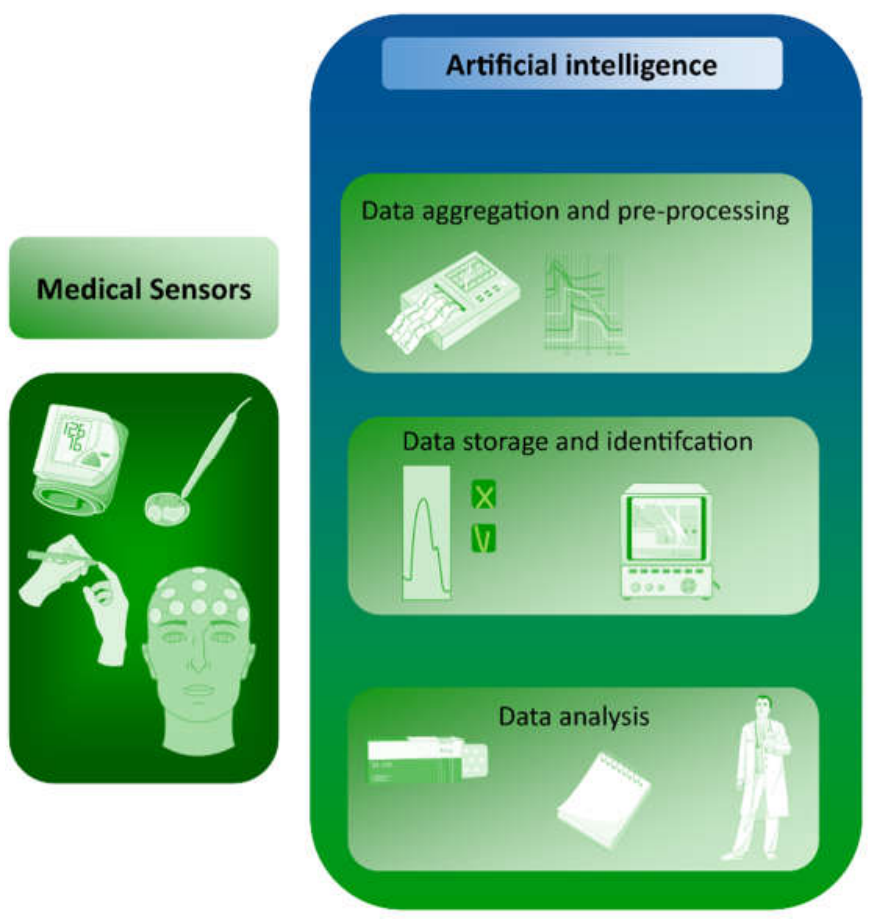
Figure 1. Applications of AI in medical sensors, from data collection to diagnosis (medical art from Smart Servier Medical Art. Available online https://smart.servier.com (accessed on 1 December